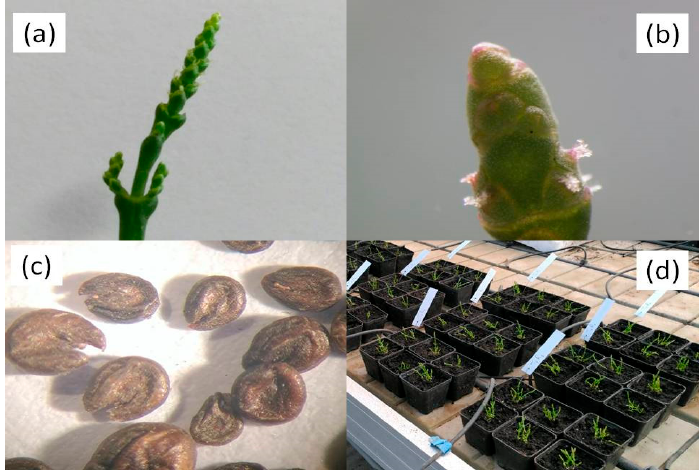
Figure 4. Salicornia europaea : ( a ) cylindric and succulent stem; ( b ) spike-like inflorescence; ( c ) seeds; ( d ) seedlings.